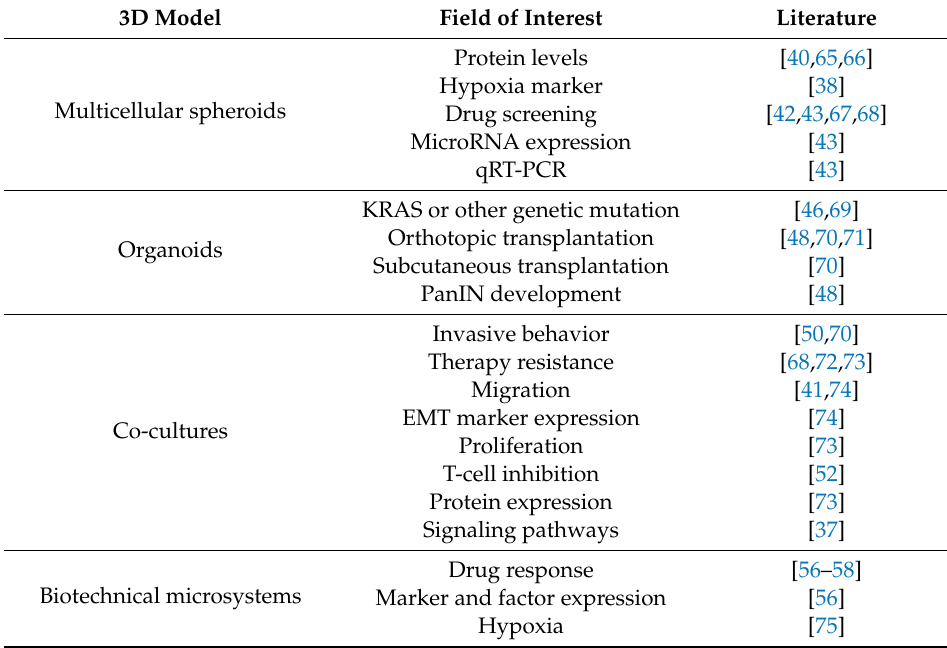
Table 2. Three-dimensional models for PDAC research and their